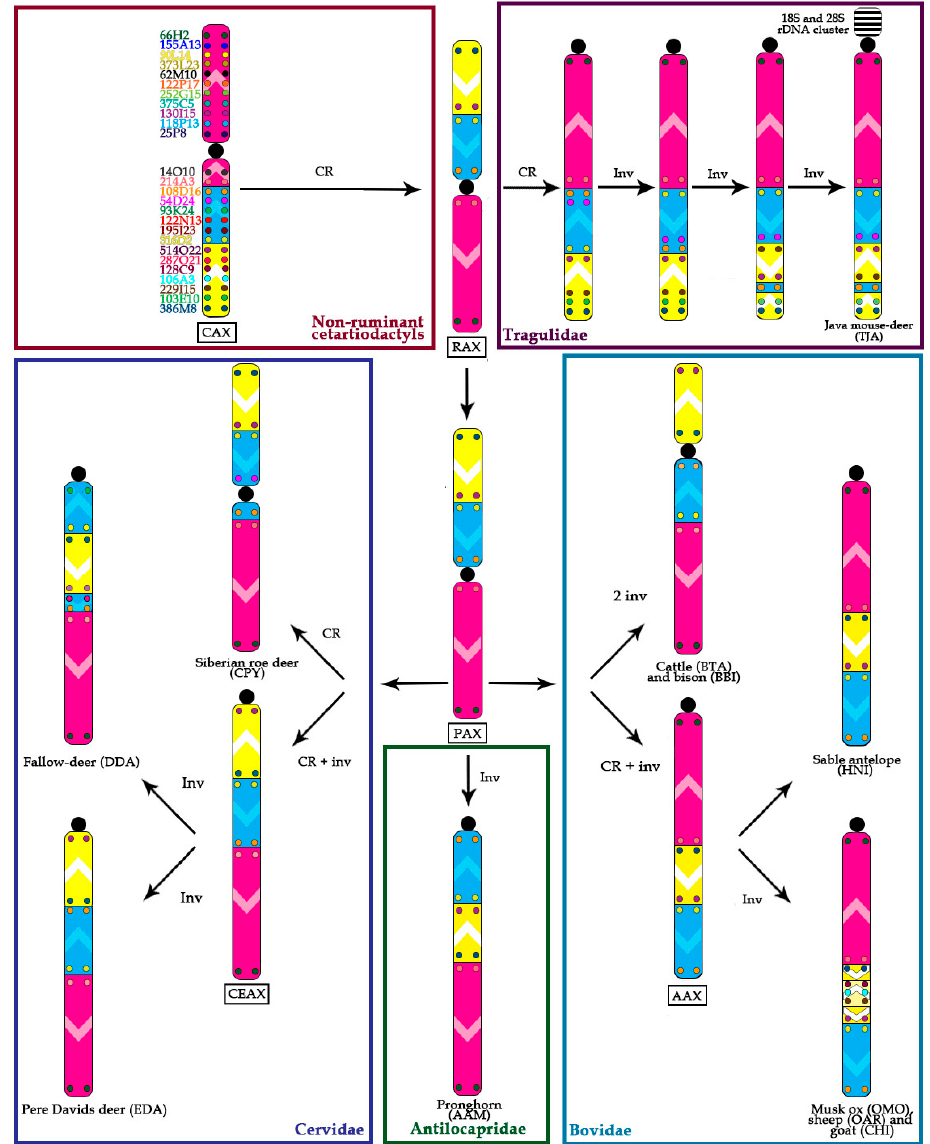
Figure 2. The scheme of evolutionary transformations of X chromosome in Cetartiodactyla. Chromosome rearrangements were identified by changes in BAC order. Three major conservative segments are designated by different colors: pink—X syntenic block 1; yellow—X syntenic block 2, and; blue—X syntenic block 3. Individual BAC clones are shown with a different color in small colored circles on corresponding conservative segment. Centromere position is indicated by a black circle. The orientation of the conservative segments is indicated by the white arrowhead. Ancestral associations are shown in black rectangle (Cetartiodactyla ancestral X (CAX), Ruminantia ancestral X (RAX), Pecora ancestral X (PAX), Antilopinae ancestral X (AAX), Cervinae ancestral X (CEAX)). CR: centromere reposition. Inv: inversion.